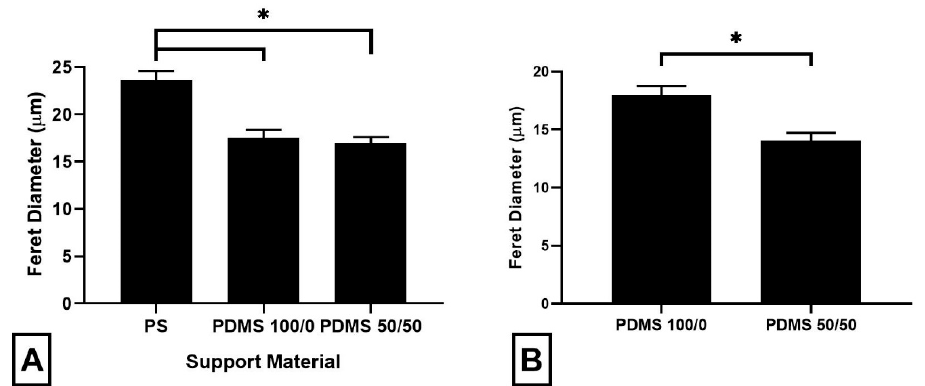
Figure 4. Glioblastoma cell Feret diameter in response to culture on 50 µm EFMs supported on substrates of declining sti ff ness ( A ) and on polydimethylsiloxane (PDMS) supports of declining sti ff ness with no EFM present ( B ). A total of 1623 cells were analyzed across at least two independent experiments. Levels connected by a star (*) are statistically